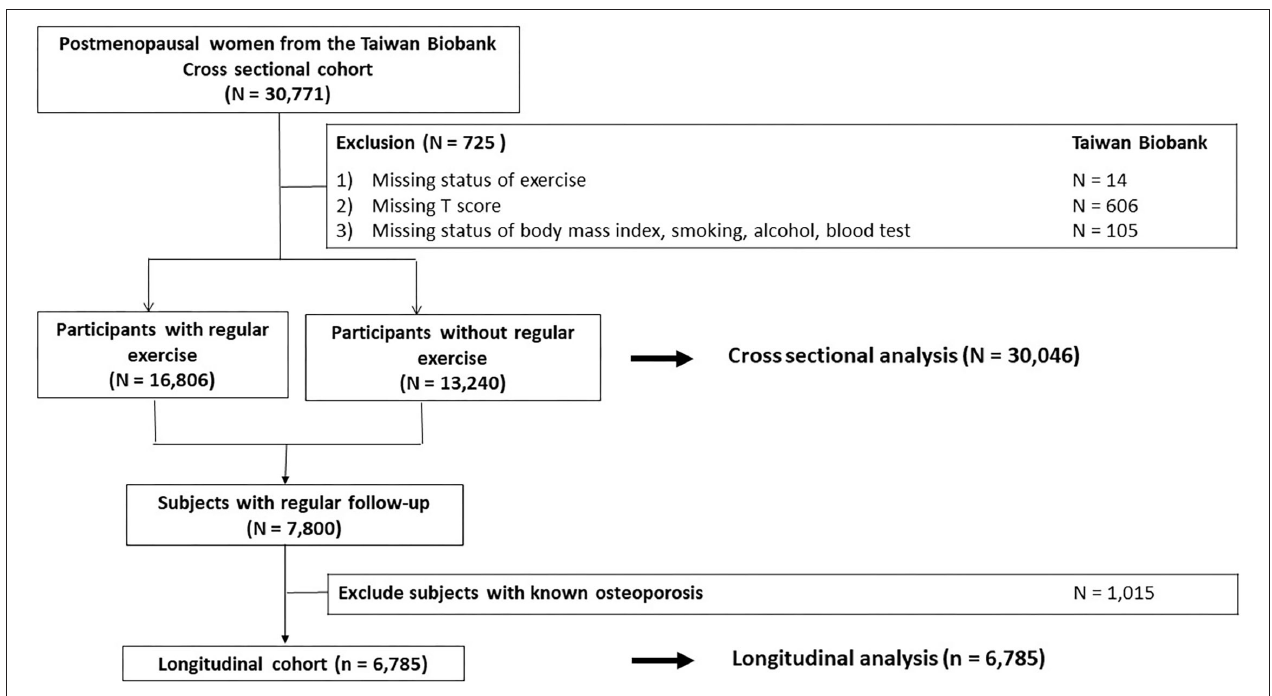
FIGURE 1 | Study participants were classified by the status of regular